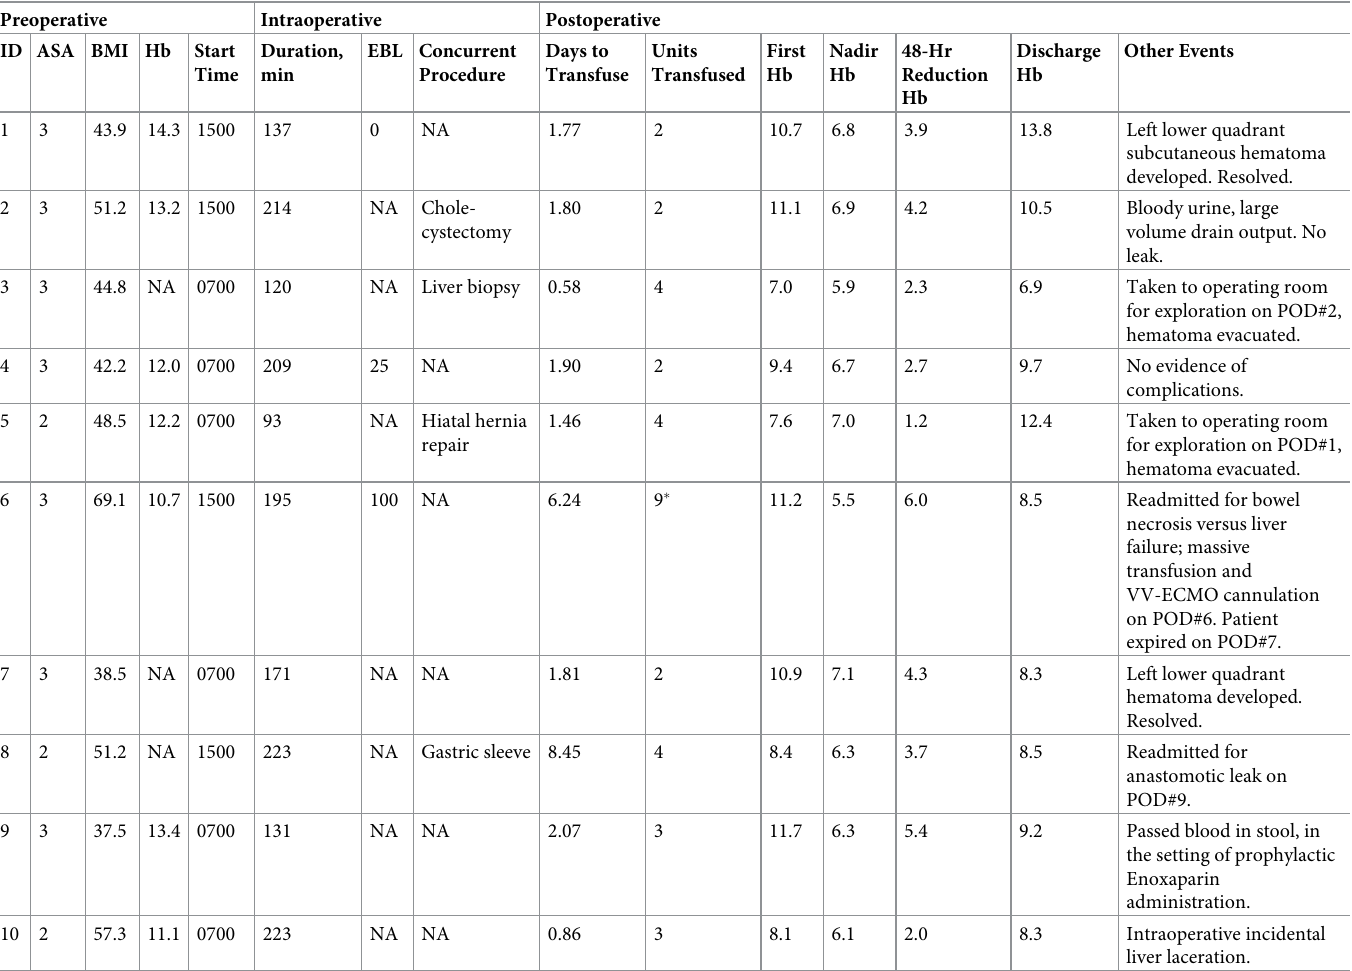
Table 4. Additional characteristics of the postoperative blood transfusion